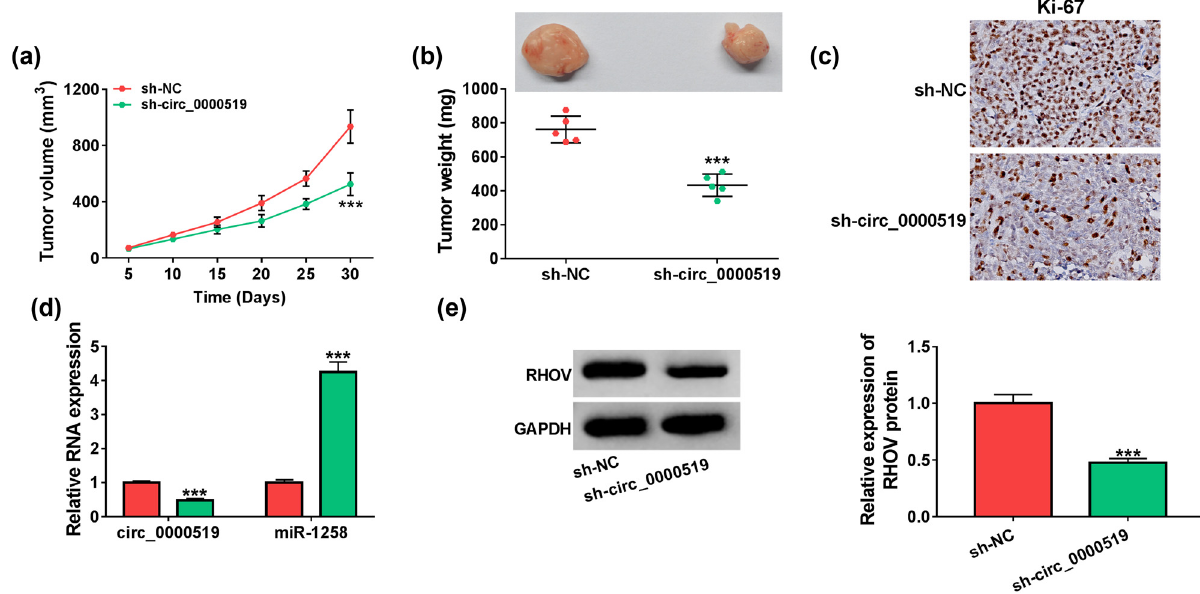
Figure 9: Exosomal circ_0000519 regulates xenograft tumor growth. The murine xenograft model was induced by injection of H2170 cells, and tumors were treated with the exosomes from H1299 cells transfected with sh - NC or sh - circ_0000519 ( named sh - NC - exo or sh - circ_0000519 - exo ) after 5 days. ( a and b ) Tumor volume and weight were examined in each group. n = 5. ( c ) The Ki - 67 level was detected by an immunohistochemistry assay. ( d and e ) circ_0000519, miR - 1258, and RHOV abundances were examined via qRT - PCR and Western blotting in each group. *** P <